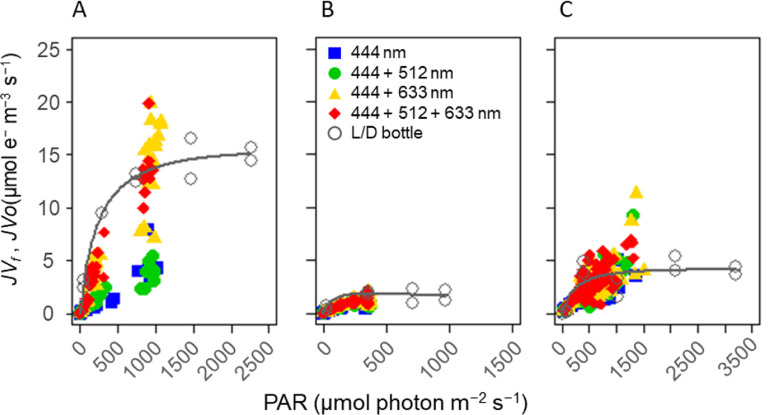
Scatter plots of JVf and JVO during cyanobacterial blooms and at other times.JVf was estimated by different combinations of excitation wavelength from the FRRf relative to ambient PAR intensity at (A) Station 9B on 28th August, (B) Station 12B on 13th September and (C) Station 6B on 18th September. The JVO estimates from the light-dark bottle method are also shown. For JVO, PAR intensity was calculated by the light intensity of growth chambers and SCF (see Materials and methods). The fitted curve is given for JVO using a two-parameter model [80] to improve visibility.